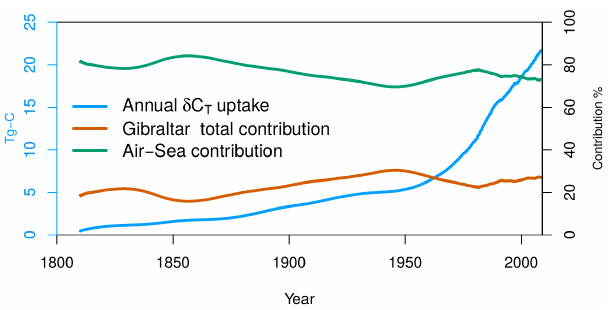
Figure 8. Evolution of the Mediterranean’s annual uptake in δC T (solid light-blue line), shown as a 10-year running average to focus on decadal-scale changes. Also shown is the percentage of that an- nual δC T that entered the Mediterranean Sea through the Strait of Gibraltar (solid orange line) and via the air–sea fluxes (solid green